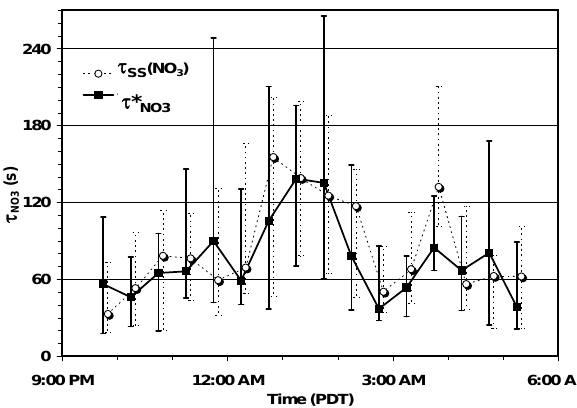
Fig. 7. Study wide nocturnal variation in median NO 3 lifetimes, including the non steady-state (non-SS) lifetimes calculated using Eq. (10), and the steady-state (SS) lifetime calculated using Eq. (3), offset by +5 min for clarity. Error bars indicate the 25th and 75th percentiles of the distributions.